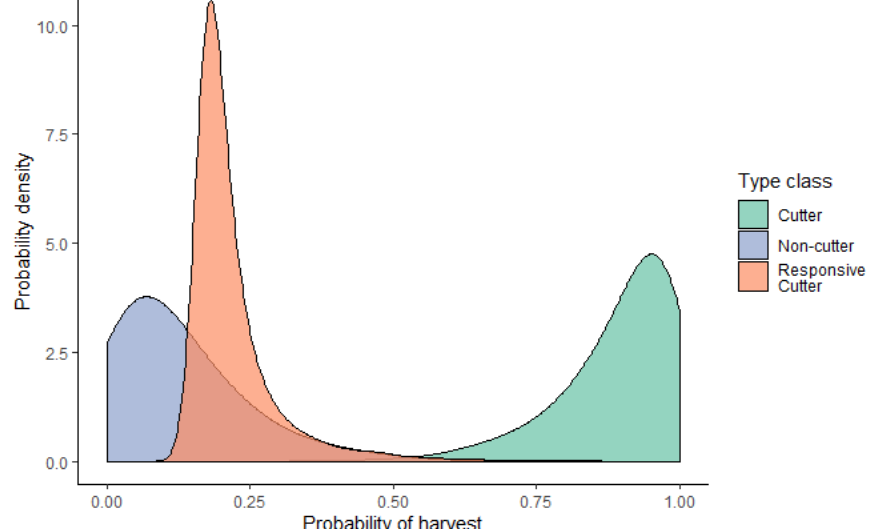
Figure 3. The distribution of harvest probabilities for each of the agent functional types for one of the 10 replicates. Other replicates had similar distributions.